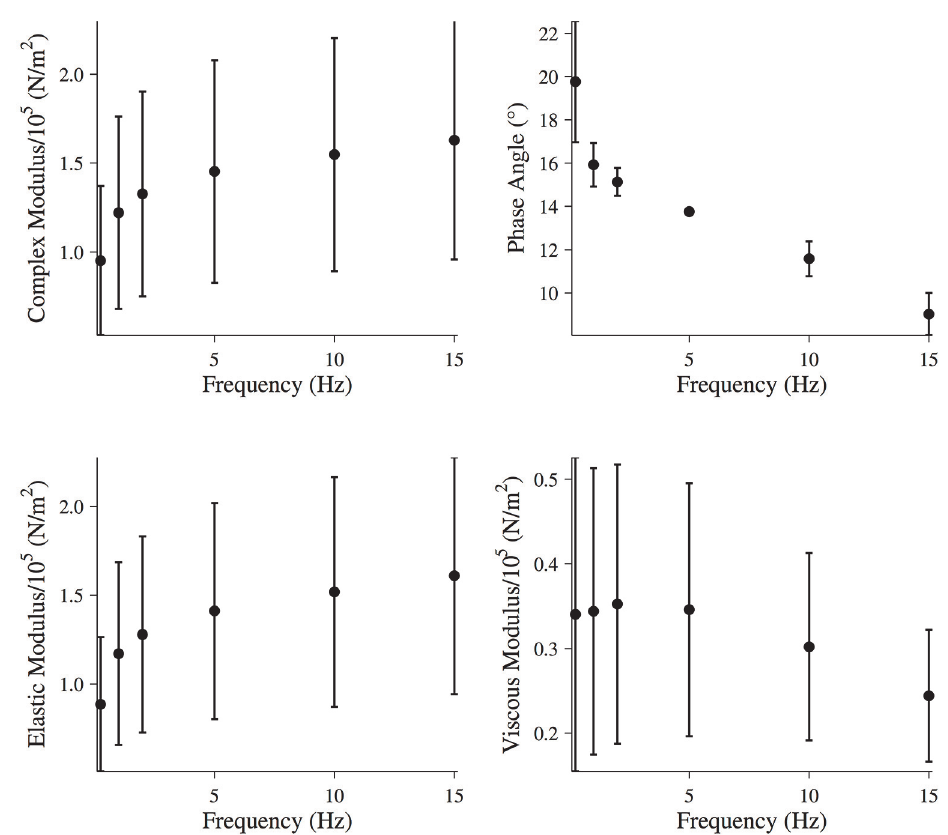
Fig 8. Mechanical properties of activated muscle fibers following treatment. Magnitude of the complex modulus, phase, elastic modulus, and viscous modulus for activated muscle fibers during the final five oscillations following treatment with EDTA and blebbistatin. All data points are (MEAN ± SEM), and the number of fibers analyzed was N = 2.